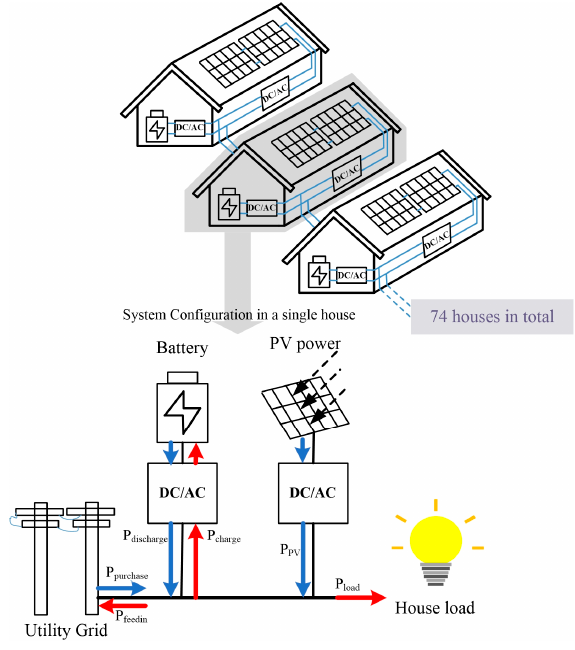
Figure 1. The investigated system scheme.